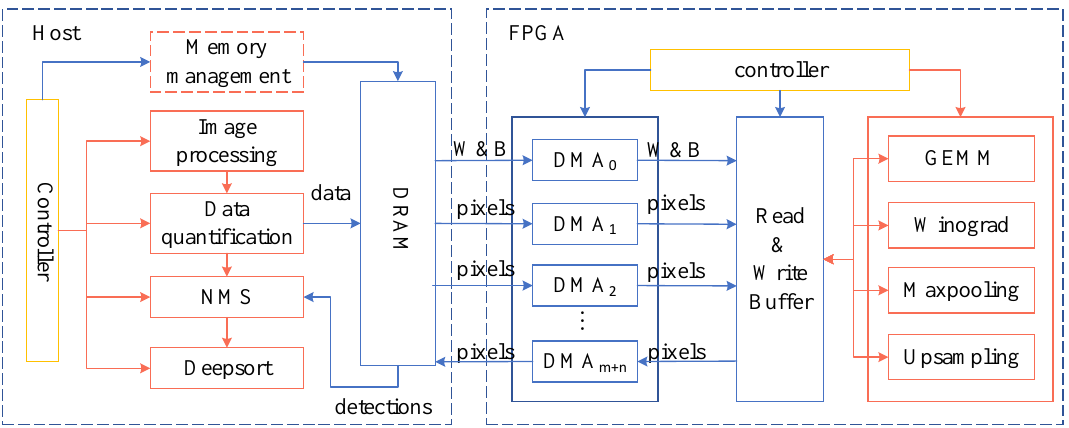
Figure 5. Overview architecture of the